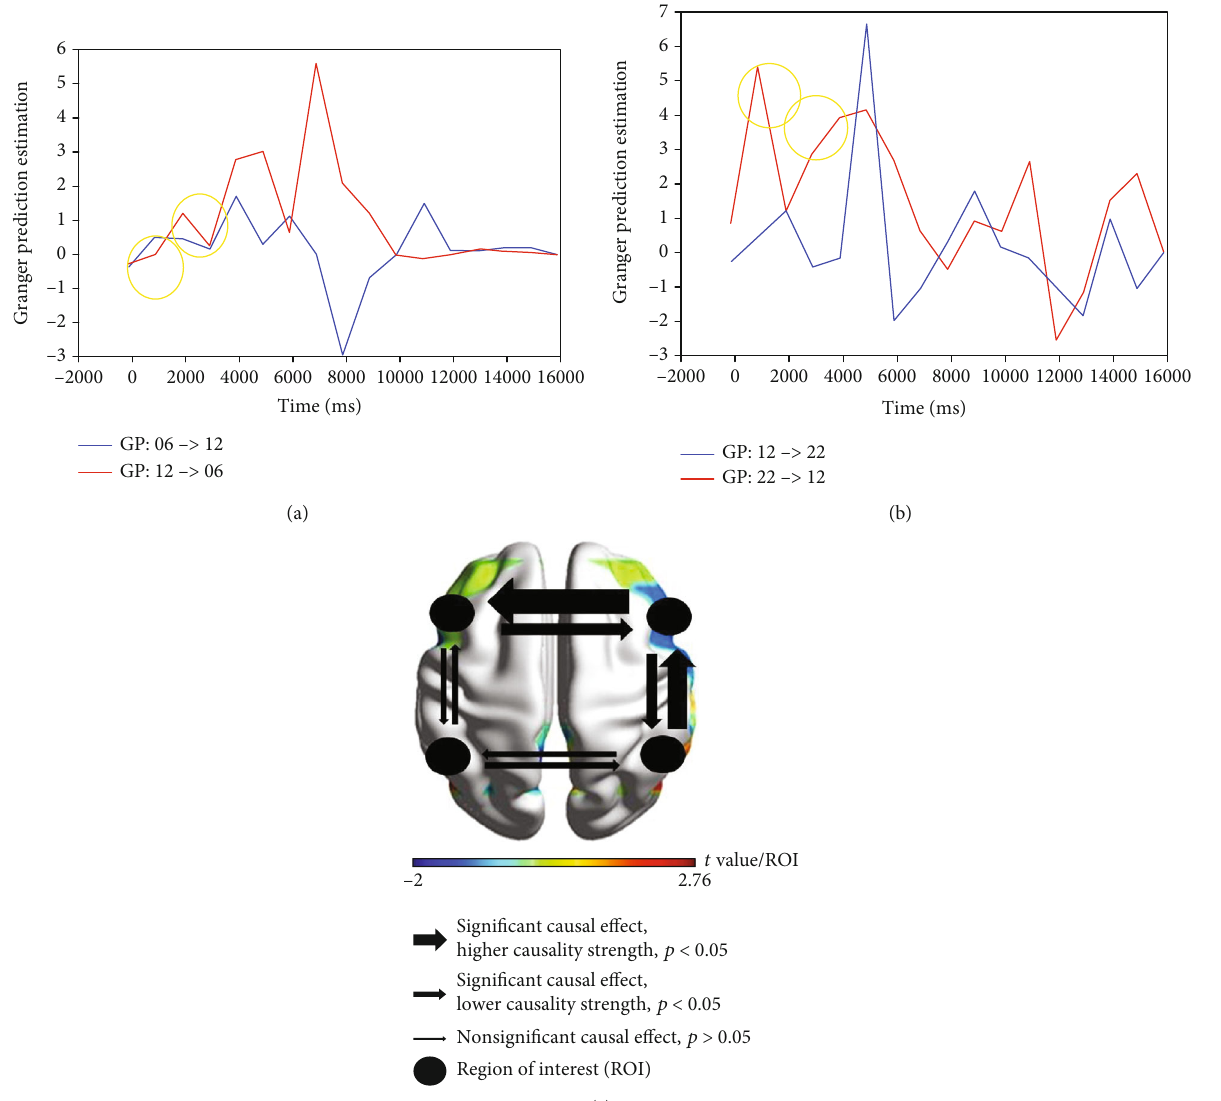
Figure 5: Granger Prediction Estimation generated directional relations measured from HBO2 measurements among signi fi cant ROIs in literal condition: (a) right Broca/Ch12 to left Broca/CH06 ( p < 0 : 045 ); (b) right Wernicke/Ch22 to right Broca/Ch14 ( p < 0 : 015 ). The fi rst yellow circle represents the onset of the fi rst trial over 500ms, and the second one represents the stimulus presentation period of the fi rst trial over 2200-2700ms interval integrating the semantic judgment period; (c) causality strength across ROI ( p < 0 : 05 ) in the literal condition during the experimental